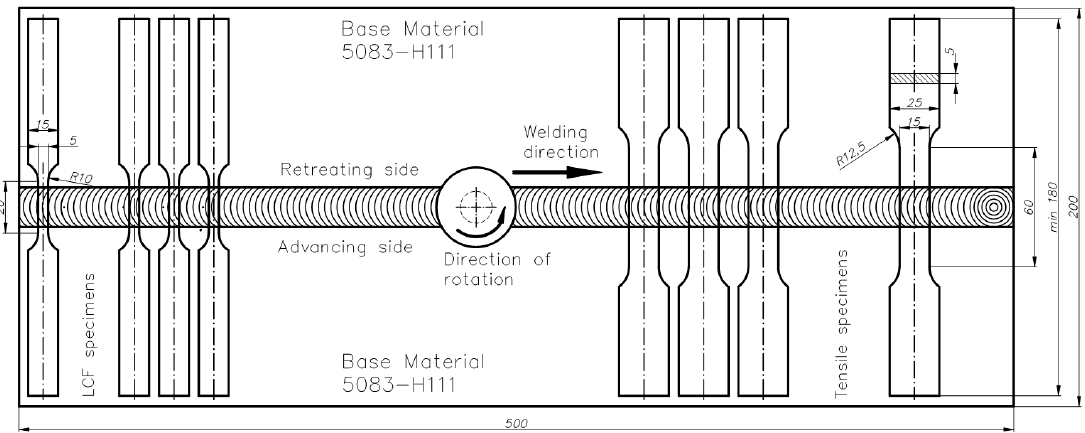
Figure 2. Arrangement of AA 5083-H111 sheets at the time of making FSW joints and dimensions of specimens used for tensile and low cycle fatigue (LCF) tests.